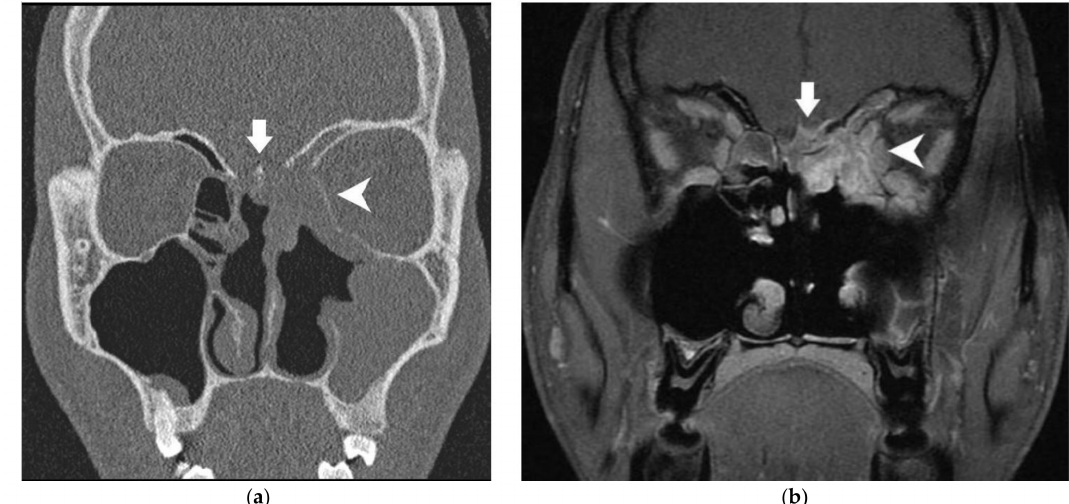
Figure 1. Twenty-year-old male subject with neuroendocrine carcinoma of the left ethmoid sinus. ( a ) Coronal CT scan- ner: minor erosion of the lamina papyracea (white arrowhead) and major erosion of the cribriform plate (white arrow). ( b ) Coronal MRI (T1 acquisition with fat saturation and gadolinium injection): white arrow: major modification of bony skull base, irregular nodular dural enhancement >2 mm, irregular deformation of the dura, contact angle ≤ 45 ◦ ; white arrowhead: major modification of lamina papyracea, regular deformation of orbital content, invasion of the fat between tumor and oculomotor muscle. In the radiological conclusion, the bony skull base, orbital medial wall and dura were considered as invaded. Cerebral parenchyma and orbital content were considered as